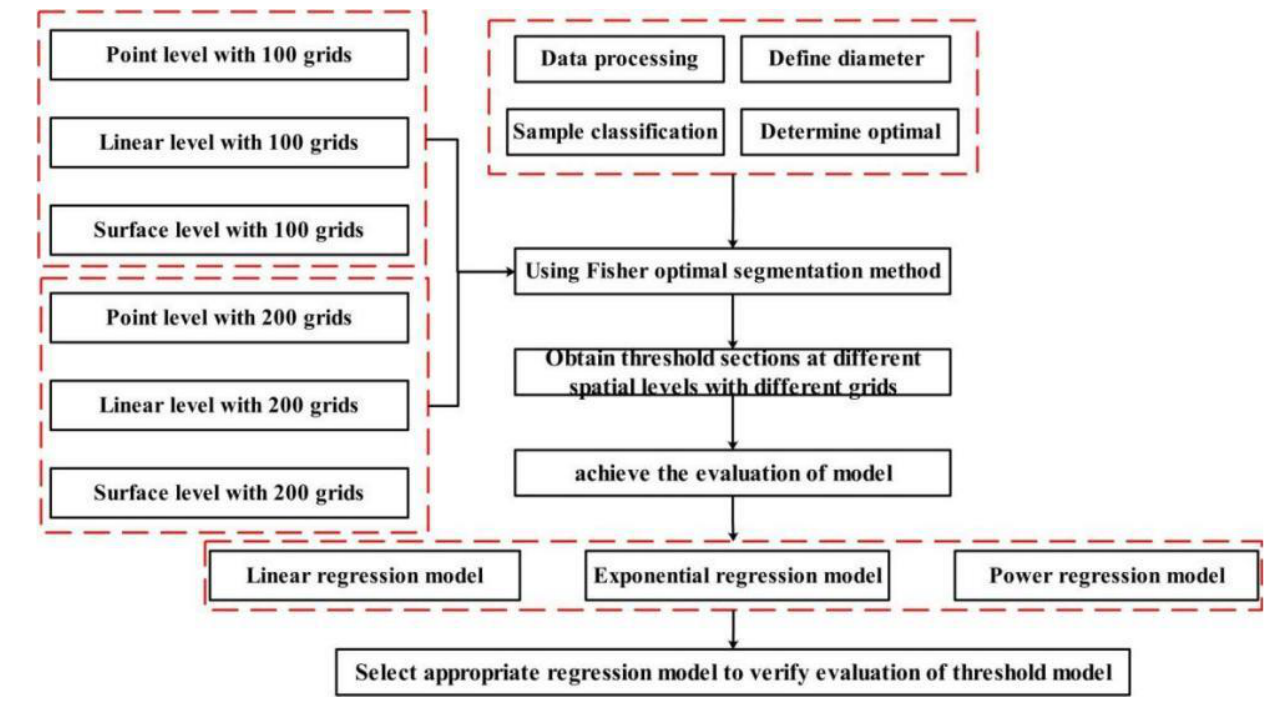
Figure 1. The technical route of the early warning threshold model.